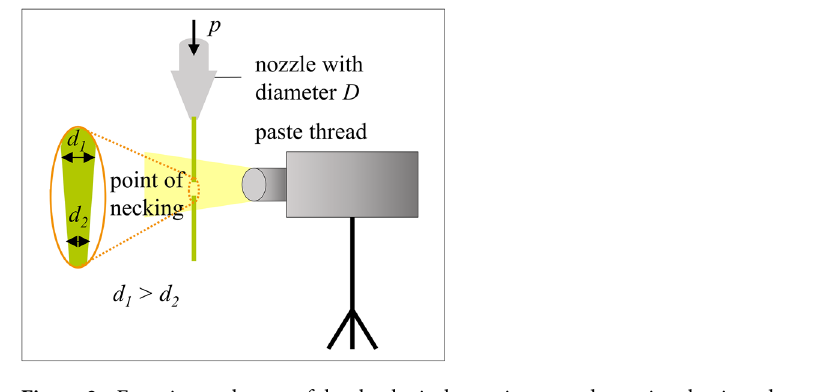
Figure 2. Experimental setup of the rheological experiment to determine the time-dependent diameter of the extruded